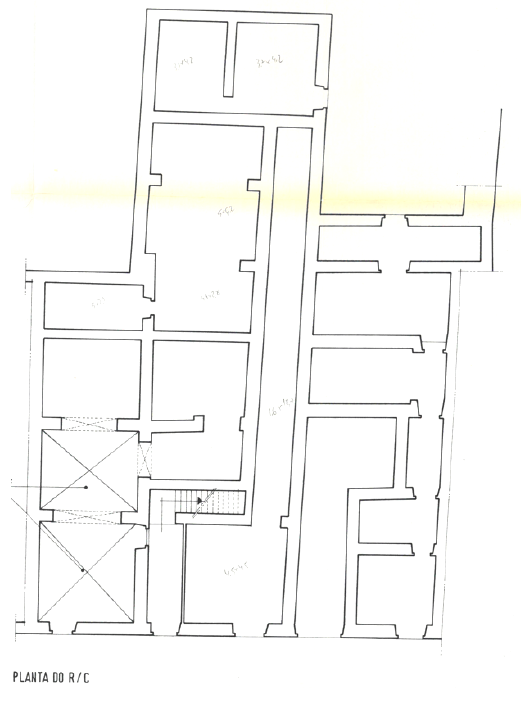
Figure 2. House in Largo dos Combatentes, 25, Borba. (Municipal Archive, Borba).